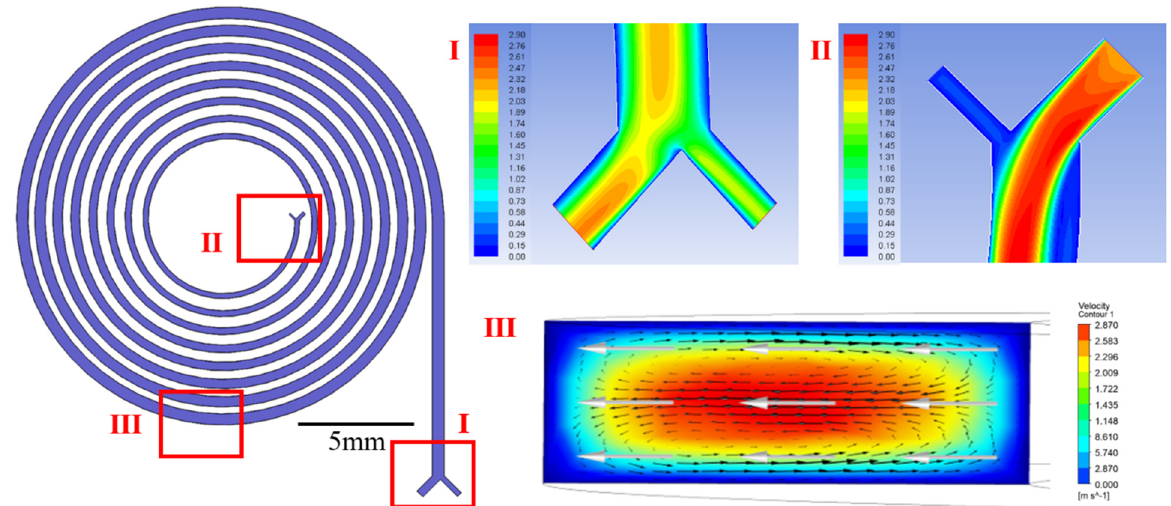
Figure 4. Distribution of flow field in the spiral inertial focusing channel, where the planar simulations of outlet and inlet are indicated by sections I and II. Section III presents the Dean vortex in the cross section of the spiral inertial channel.